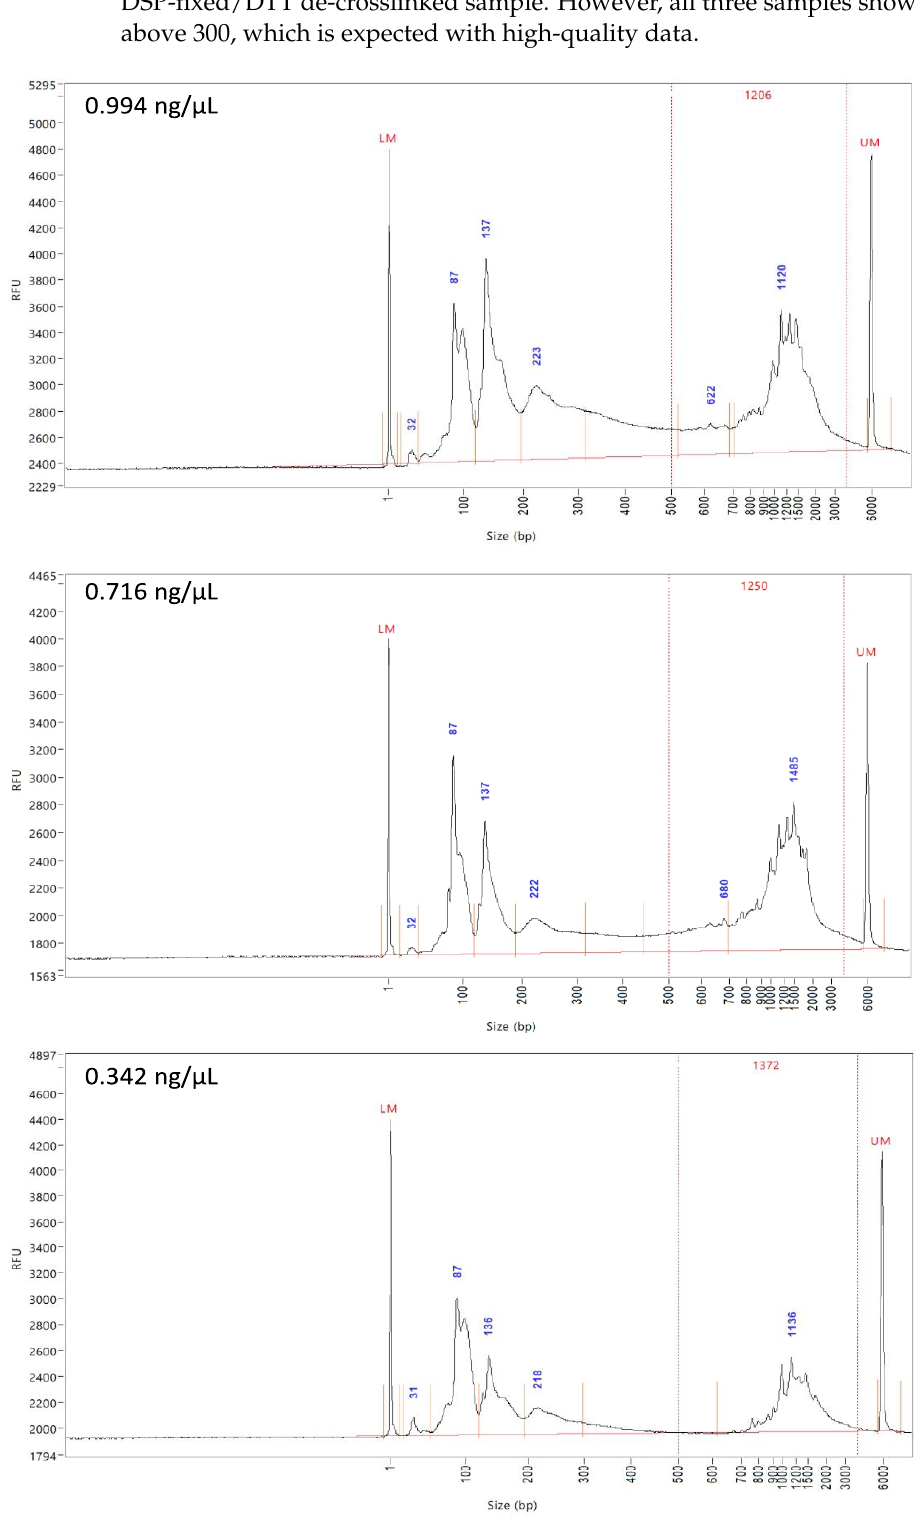
Figure 4. Fragment analysis of the cDNA profiles before library preparation. cDNA profiles of unfixed cells ( A ), DSP-fixed cells ( B ), and DSP-fixed/DTT de-crosslinked cells ( C ) were analyzed for cDNA lengths. cDNA concentration of each processed sample is provided.